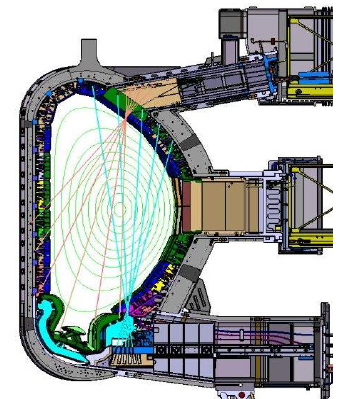
Fig. 1. Vertical Neutron Camera layout.